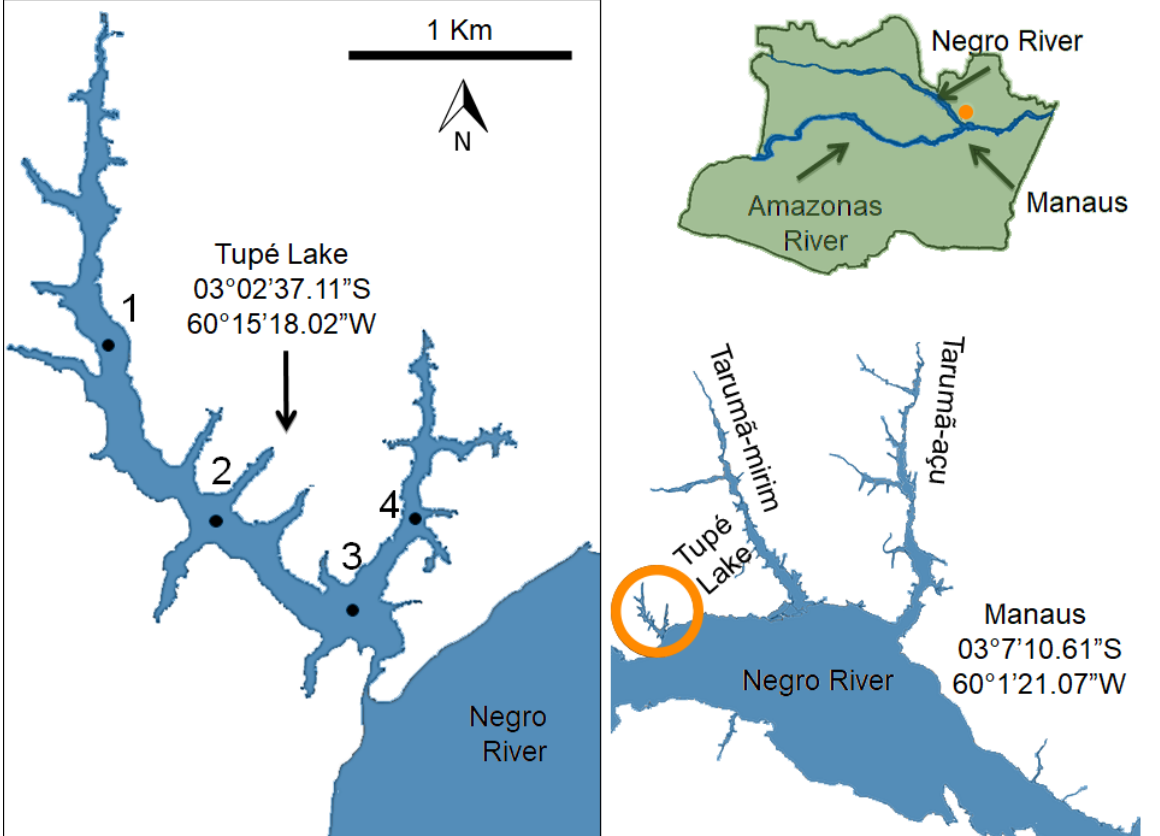
Figure 1. Map of Tupé Lake, Amazonas State, Brazil, indicating the study site and sampling